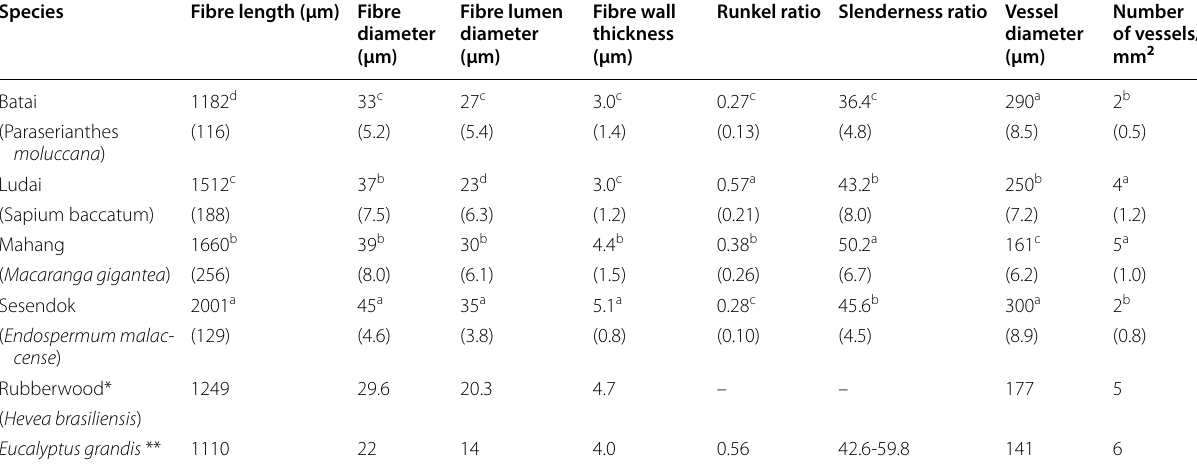
Table 1 Anatomical properties of batai, ludai, mahang, and sesendok in comparison with other well-known plantation